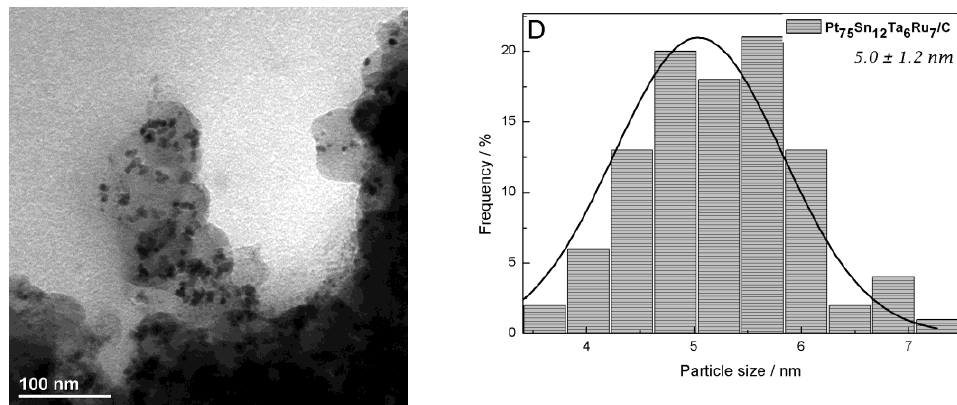
Figure 2. TEM images and histograms of particle size distributions of PtSn/C catalysts modified with Ta and Ru. ( A ) Pt 63 Sn 13 Ta 24 , ( B ) Pt 50 Sn 21 Ta 24 Ru 4 , ( C ) Pt 60 Sn 15 Ta 18 Ru 7 and ( D ) Pt 75 Sn 12 Ta 6 Ru 7 .